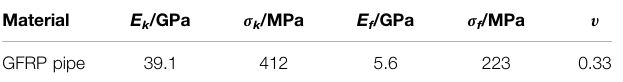
TABLE 2 | Mechanical properties of GFRP pipe.